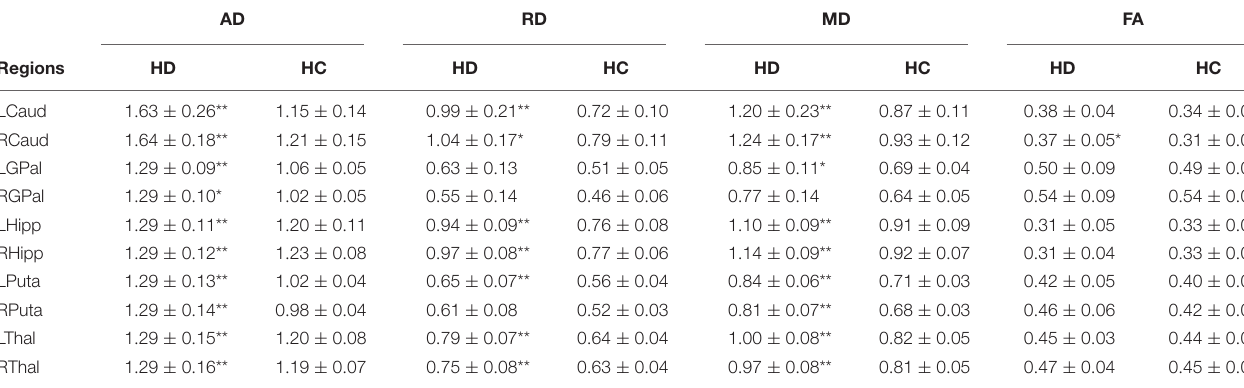
TABLE 2 | Tensor derived indices in patients with HD and healthy control